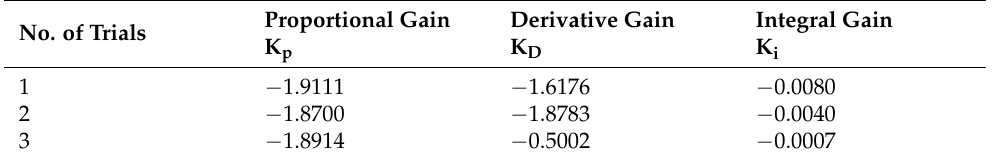
Table 7. Optimized GOA result for controller gains network 3. [K A = 0.1072, K B = 0.0143, K pp =